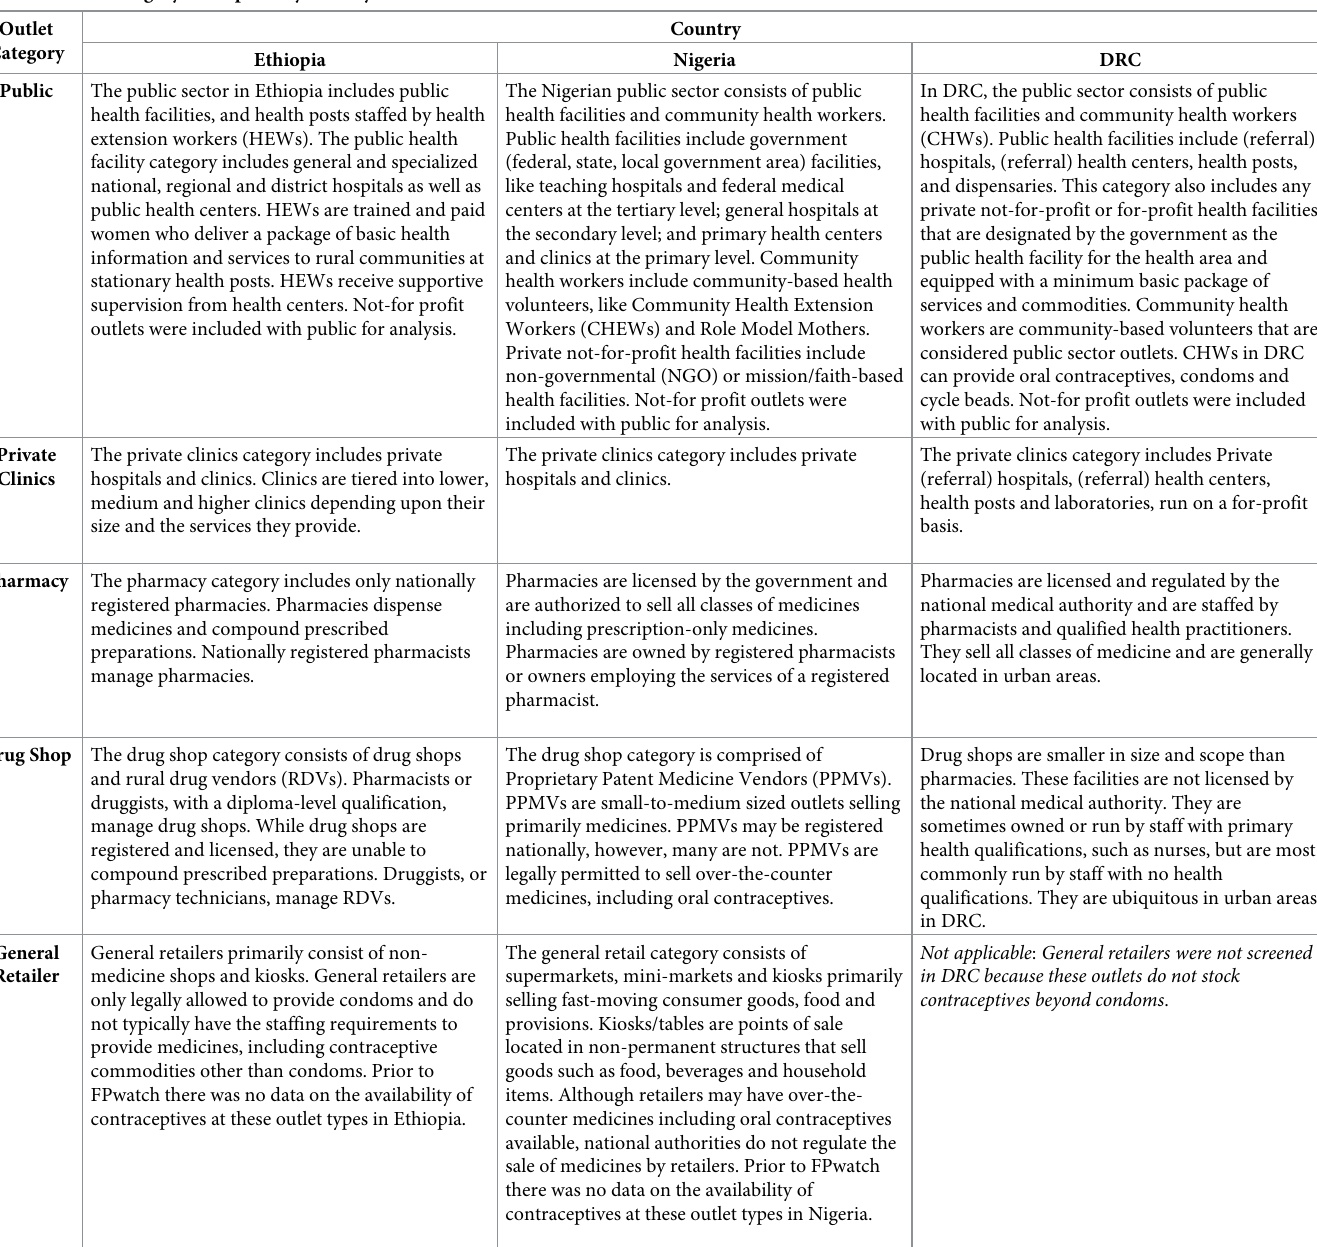
Table 1. Outlet category description by